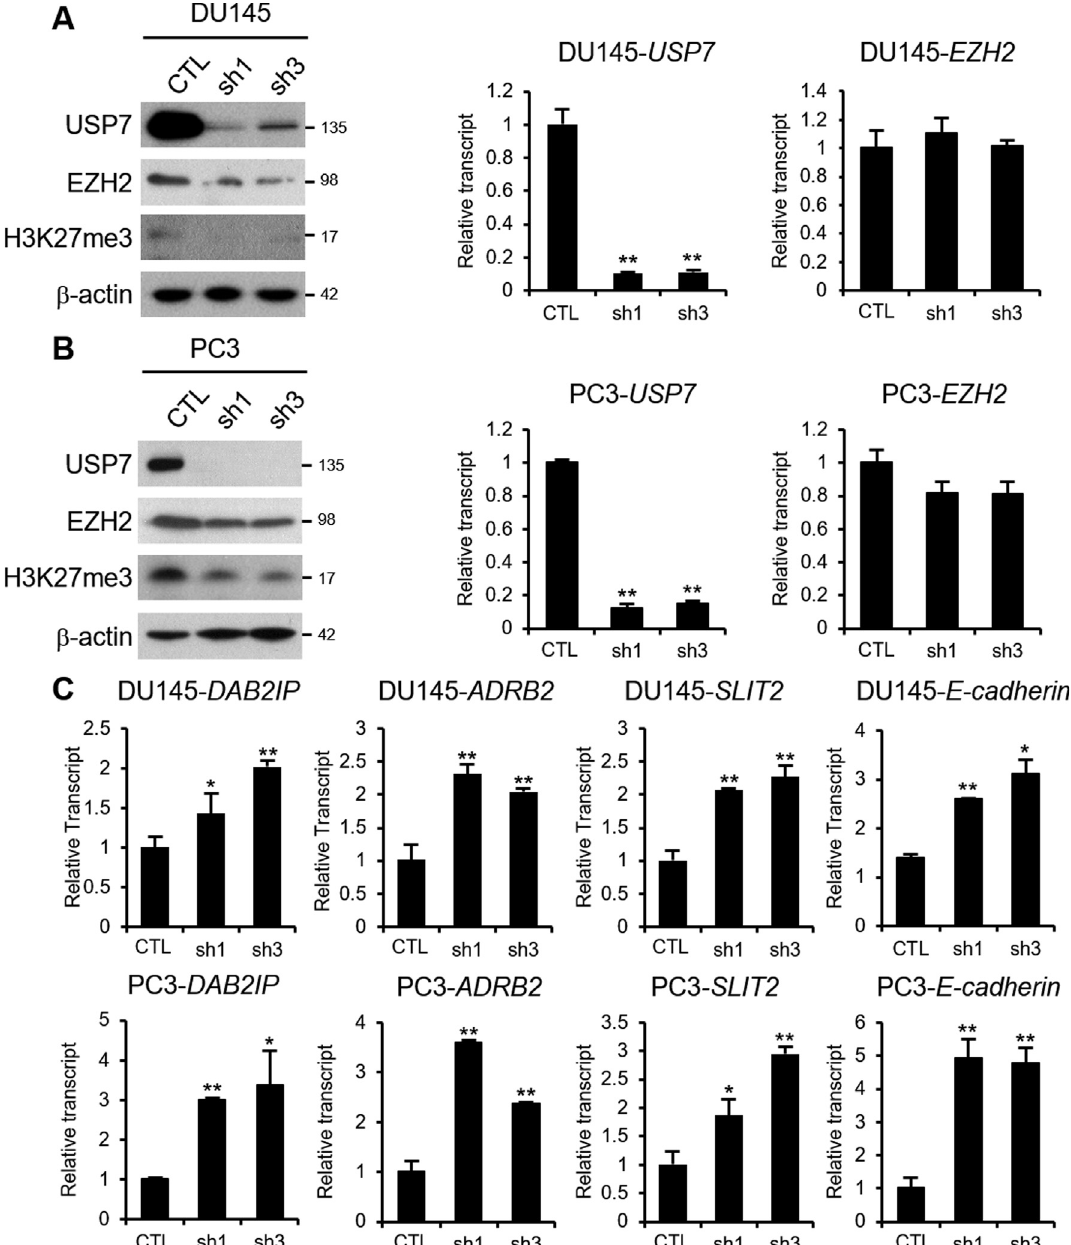
Figure 4 - EZH2-repressive target genes are derepressed by USP7-knockdown. (A) Western blot analysis of USP7, EZH2, and H3K27me3 levels in USP7-knockdown DU145 cells. Real-time RT-PCR analysis of the transcript levels of USP7 and EZH2 in USP7-knockdown DU145 cells. (B) Western blot analysis of USP7, EZH2, and H3K27me3 levels in USP7-knockdown PC3 cells. Real-time RT-PCR analysis of the transcript levels of USP7 and EZH2 in USP7-knockdown PC3 cells. (C) Real-time RT-PCR analysis of the transcript levels of DAB2IP , ADRB2 , SLIT2 , and E-cadherin in USP7-knockdown DU145 or PC3 cells. Values are expressed as the mean (cid:6) SD of three independent experiments. The p value was obtained by Student’s t -test. * p < 0.05, ** p <